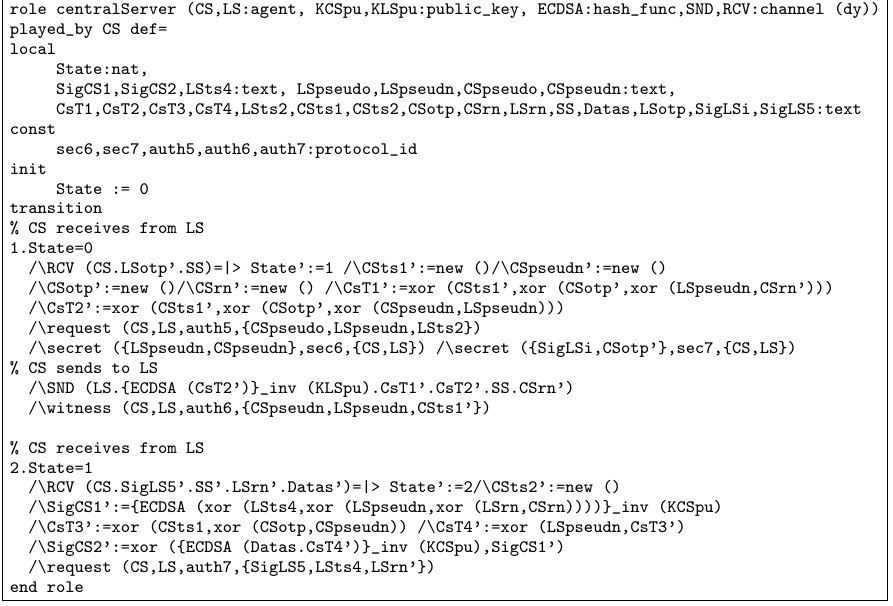
Figure 13. CS server role in